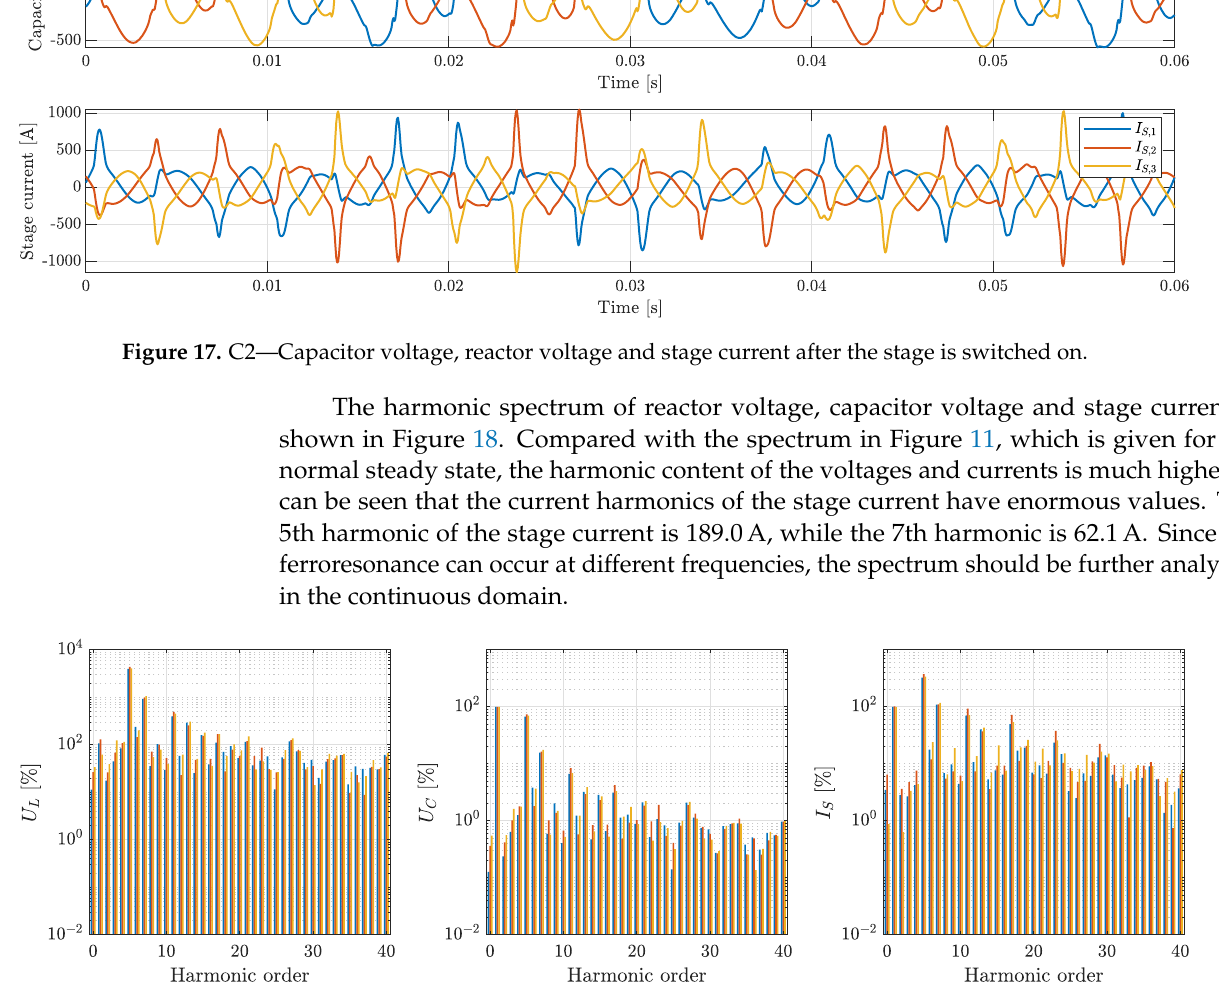
Figure 18. C2—Harmonic spectrum of reactor voltage, capacitor voltage and stage current in ferroresonance steady